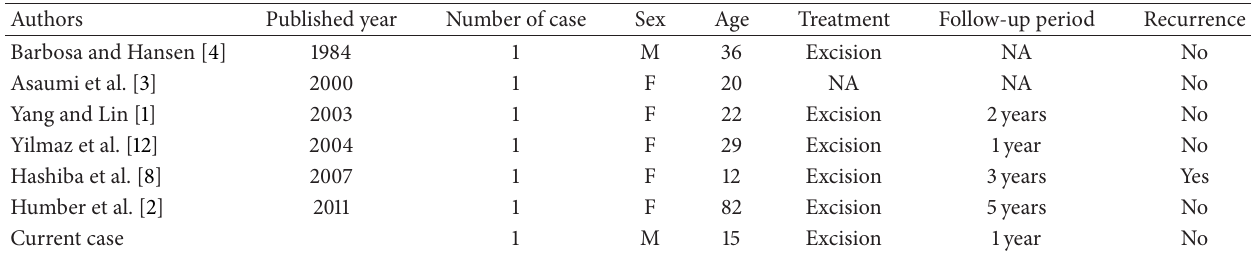
Table 1: Reported cases of schwannomas of the upper lip.